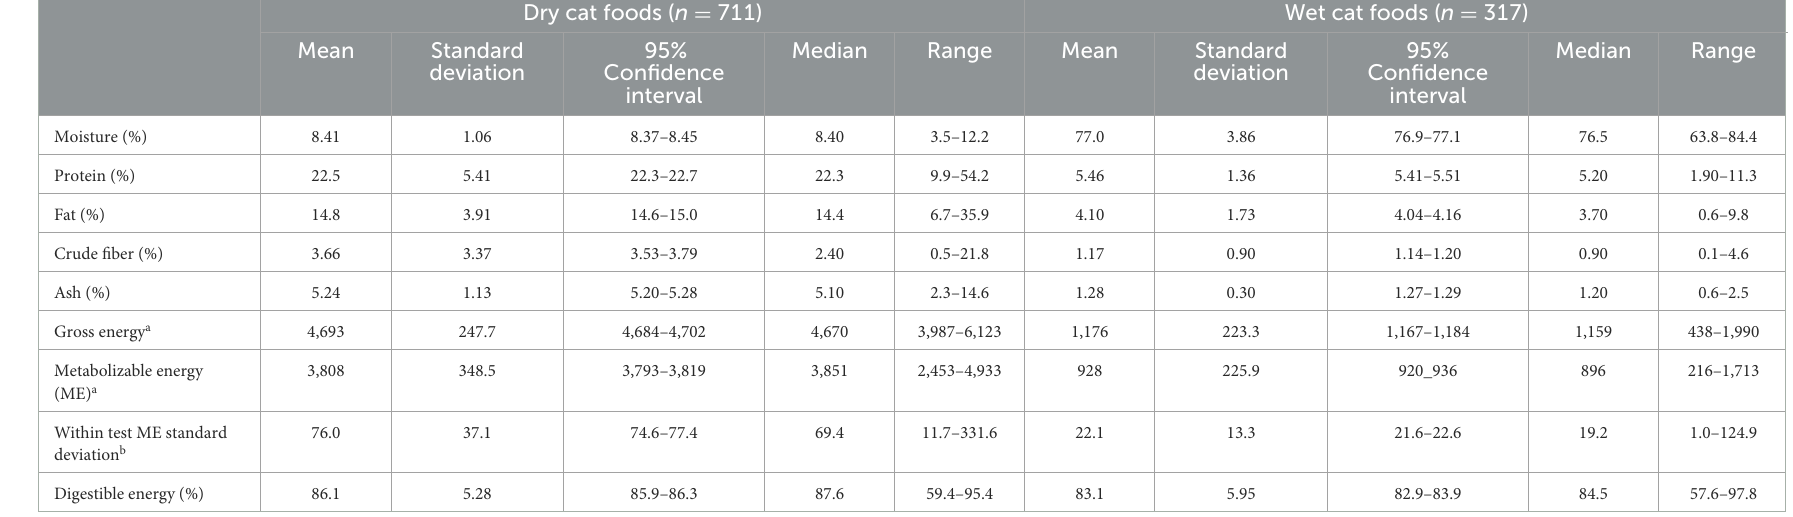
TABLE 3 Characteristics of dog foods